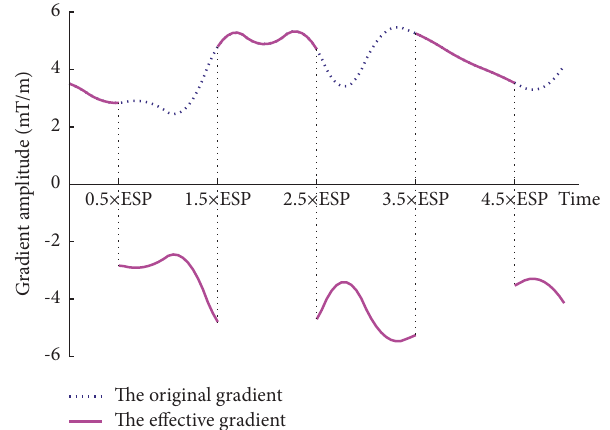
Figure 1: Te relationship between the original gradient (blue dotted line) and the efective gradient (solid magenta line) in the presence of fve 180 ° refocusing pulses. ESP represents the echo- spacing time between two adjacent 180 ° refocusing